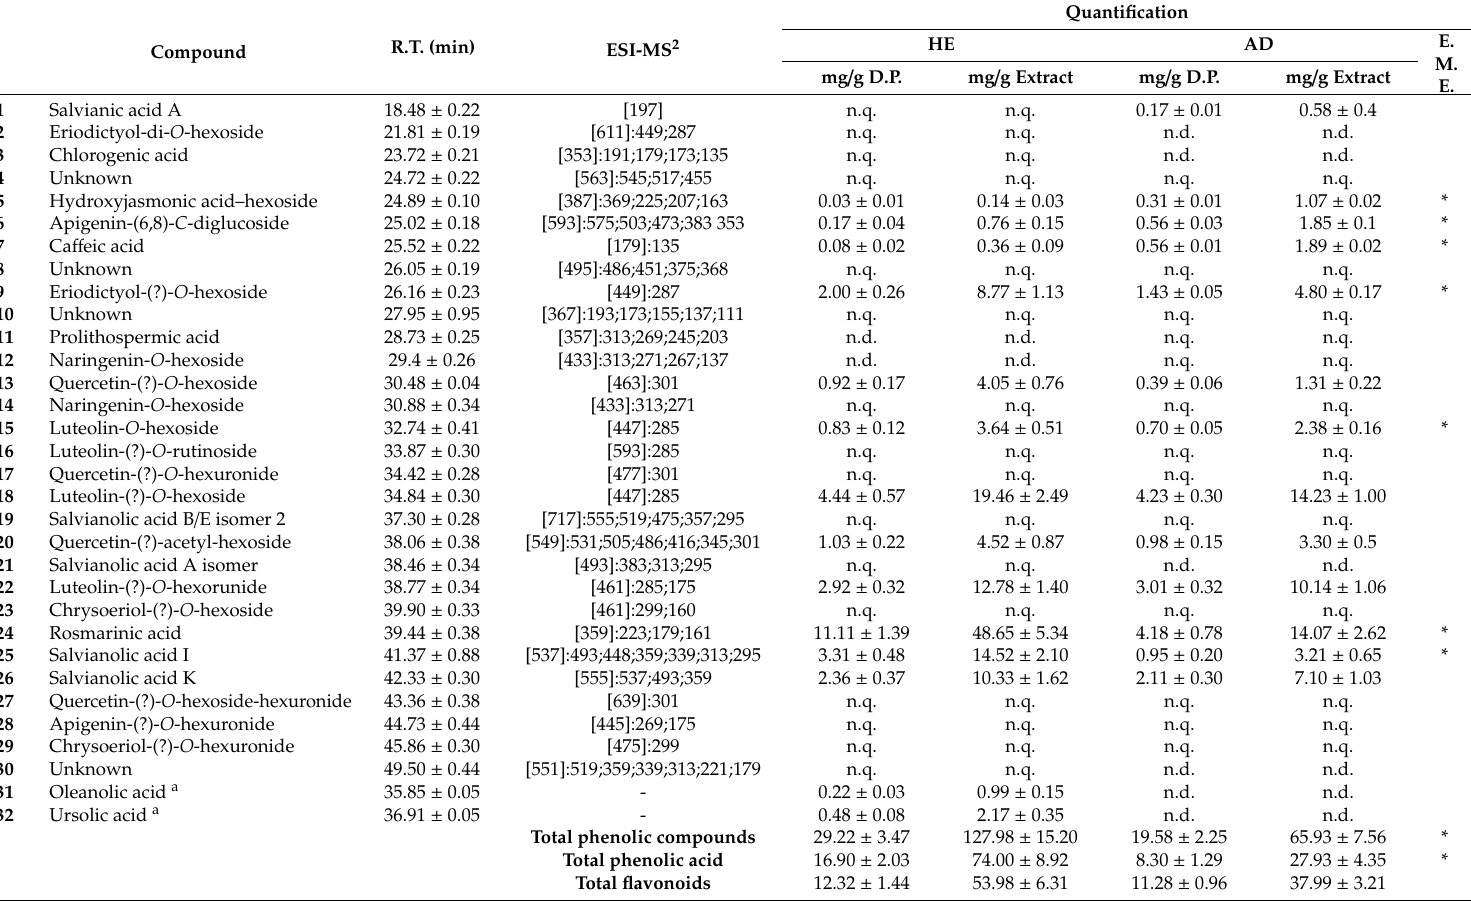
Table 2. Phytochemical composition of Thymus zygis subsp. zygis hydroethanolic (HE) and aqueous decoction (AD) extracts determined by high performance liquid chromatography coupled to diode array detector and electrospray ionization mass